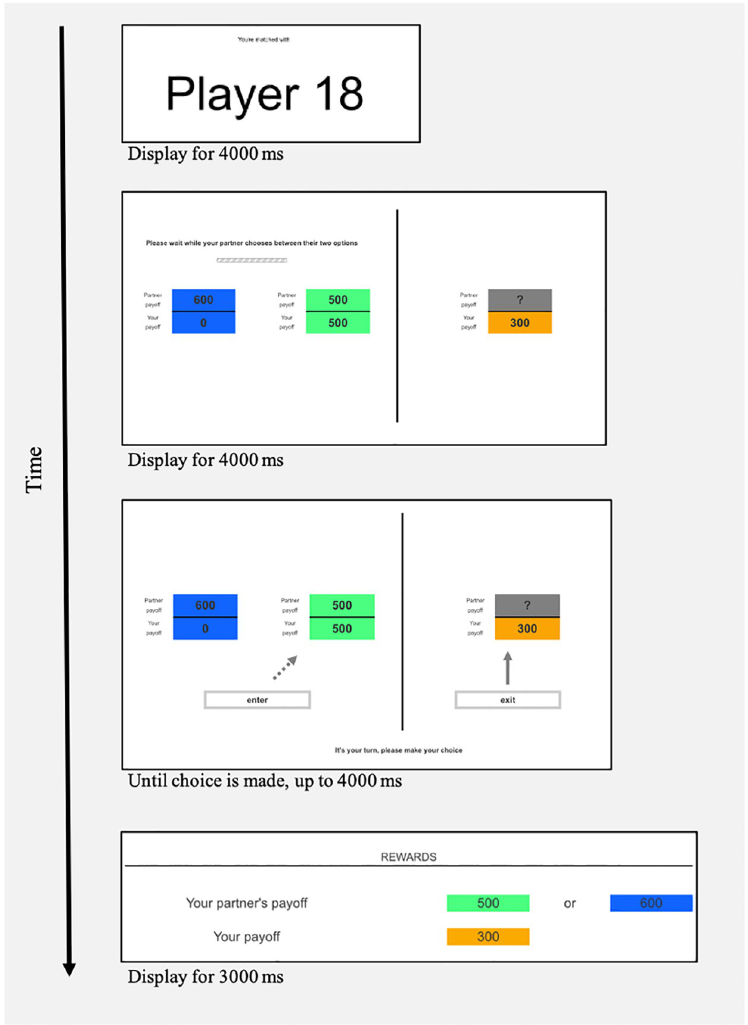
Fig 5. Experiment 2 trial structure. At the beginning of each trial an image of the partner’s player number was displayed, which was either the same (Fixed Partner Condition) or different (Variable Partners Condition) on every trial. Next, two boxes (coloured in green and blue respectively) containing payoff options appeared on the screen, and the participant waited for a fixed duration of 4000 ms while the partner ostensibly selected one of these two boxes. Crucially, participants were led to believe that one of the options presented to the partner was a more or less tempting alternative option. Participants then chose whether to trust (i.e. to select the blue or green box) if they expected that their partner had previously chosen this same option, or to exit (i.e. to select the alternative option, in orange) if they did not trust their partner to have chosen the mutually beneficial option. Participants’ alternative options always entailed a lower